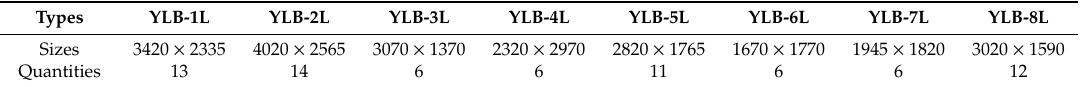
Table 2. Types and quantities of precast slabs.